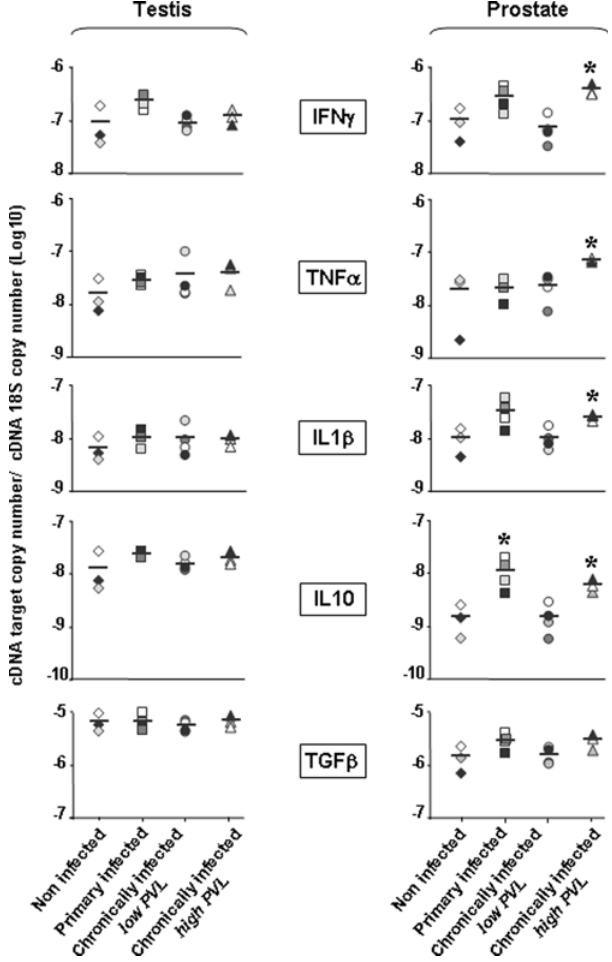
Figure 8. Cytokine mRNAs expression. Pro-inflammatory and immunosuppressive cytokines transcripts expression in testis and prostate tissues, as measured by quantitative real time RT-PCR. Each point represents the mean cytokine copy number of 2 independent fragments from one animal. Stars indicate statistical difference between non-infected and infected-macaques (Kruskal-Wallis test, p , 0.05).